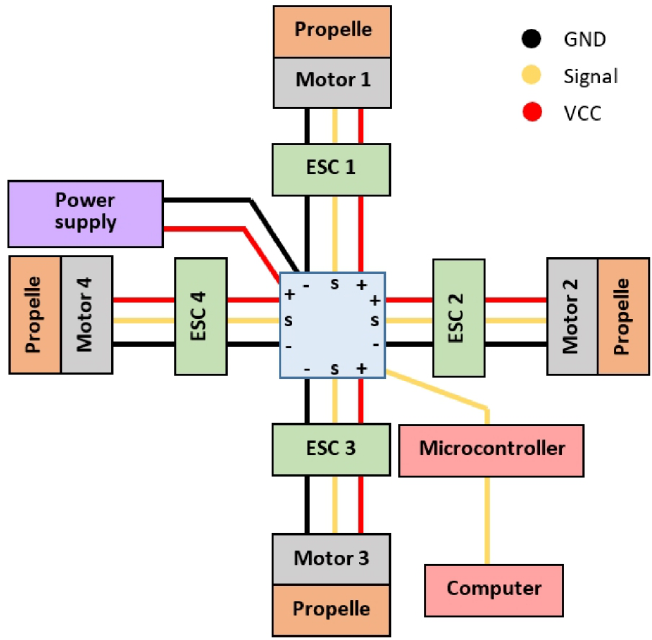
Figure 7. Quadcopter electrical connection